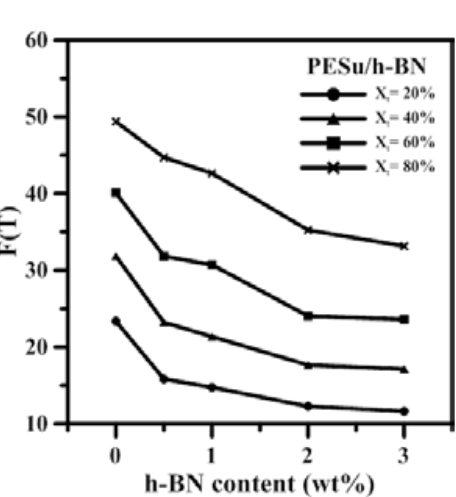
Figure 8. The fitting results of the Mo model on the non-isothermal crystallization behavior of various PESu/h-BN composites. The PESu/h-BN compositions (wt.%) are: ( a ) 100/0; ( b ) 99.5/0.5; ( c ) 99/1; ( d ) 98/2; and ( e ) 97/3.